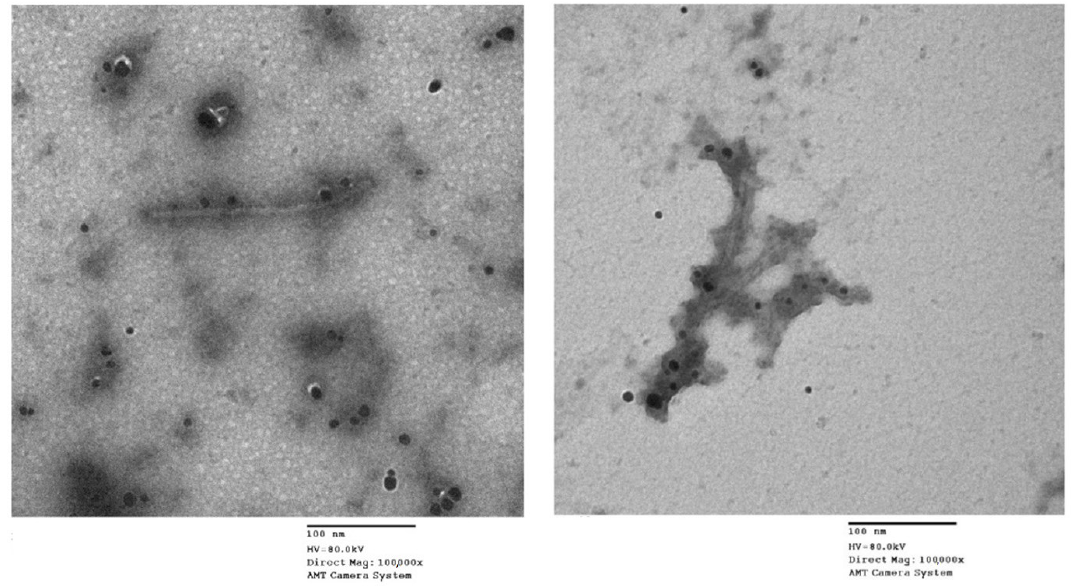
Figure 2. Transmission electron microscope (TEM) images of Tomato mosaic virus particles treated with zinc oxide nanoparti- cles (ZnO-NPs) in vitro for 2 h.